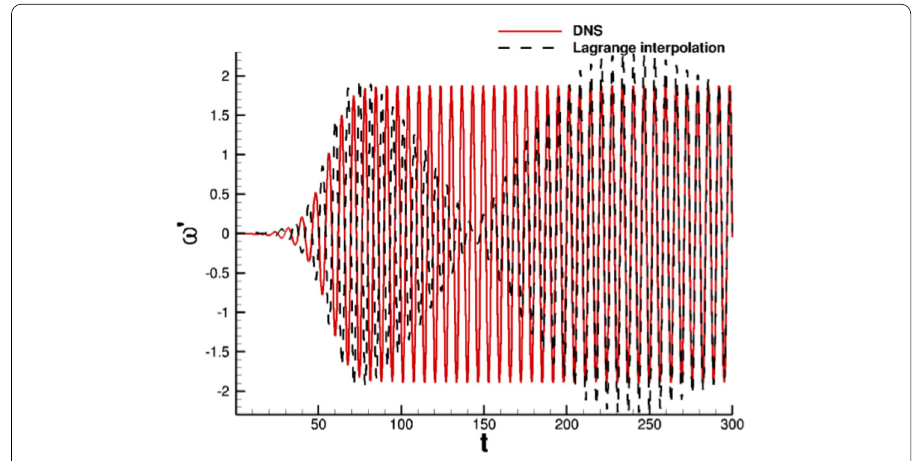
Fig. 2 Direct Lagrange interpolation of DNS vorticity disturbance time series between Re causes wave packets in the cylinder wake at point (0.504,